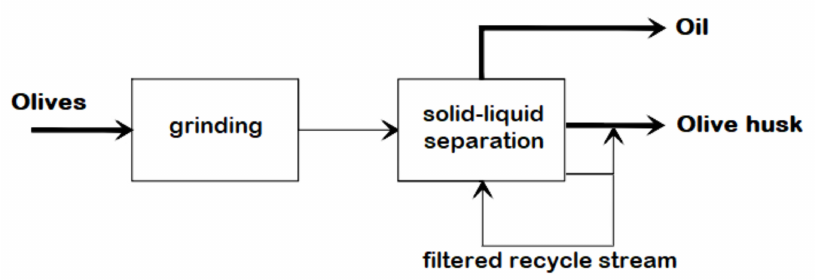
Figure 6. Conversion of a three-phase system into a two-phase system by recycling VW